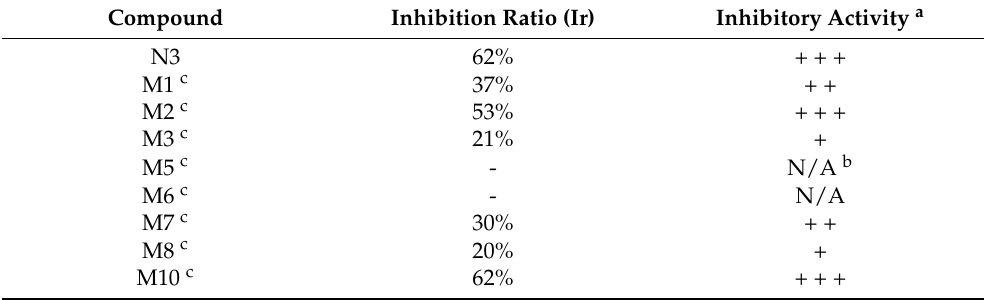
Table 4. Evaluation of the inhibitory activity of compounds targeting PDCoV M pro . The inhibition ratio (Ir) is defined as the percent inactivation of the initial enzymatic activity of PDCoV M pro .